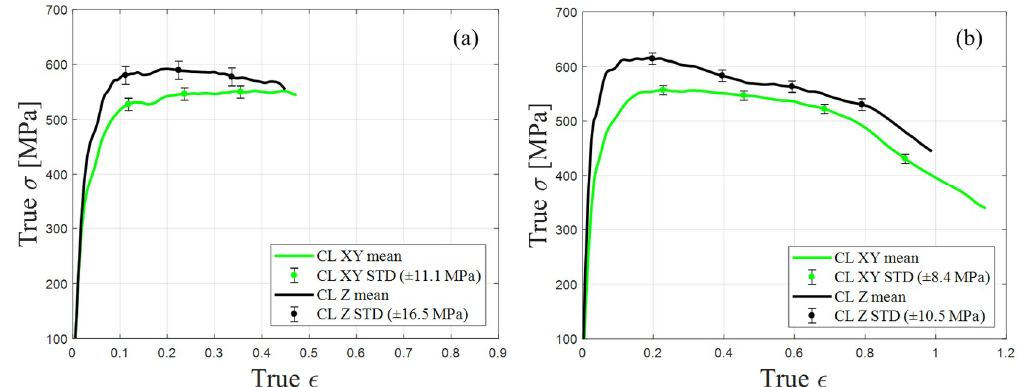
Figure 10. CL samples’ mean value and standard deviation (STD) of true stress–true strain curves: ( a ) comparison between XY- and Z-oriented samples at true strain rate range of 700 to 2800 s − 1 ; ( b ) comparison between XY- and Z-oriented samples at true strain rate range of 4000 to 6700 s − 1 .